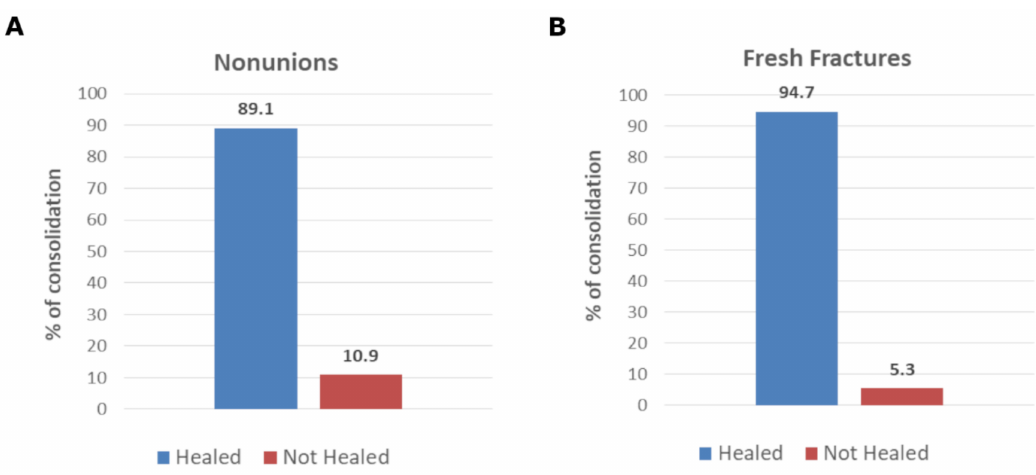
Figure 1. Percentage of healing in nonunions ( A ) and fresh fractures ( B ). Figure 2 shows a typical case that has reached bone